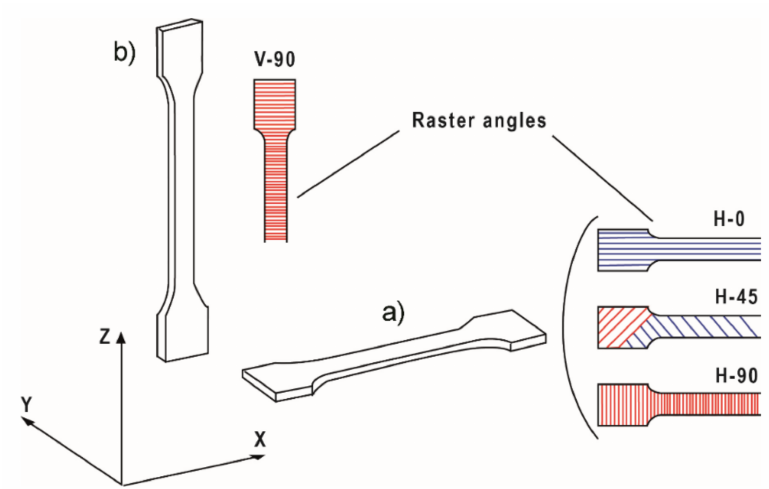
Figure 1. Orientations and raster angles of the different tensile test specimens. ( a ) Horizontal orien- tation, with raster angles parallel to the building axis, X, (0 ◦ , H-0), ± 45 ◦ (H-45), and perpendicular (90 ◦ , H-90); ( b ) vertical orientation with the raster angle perpendicular to the building axis, Z,